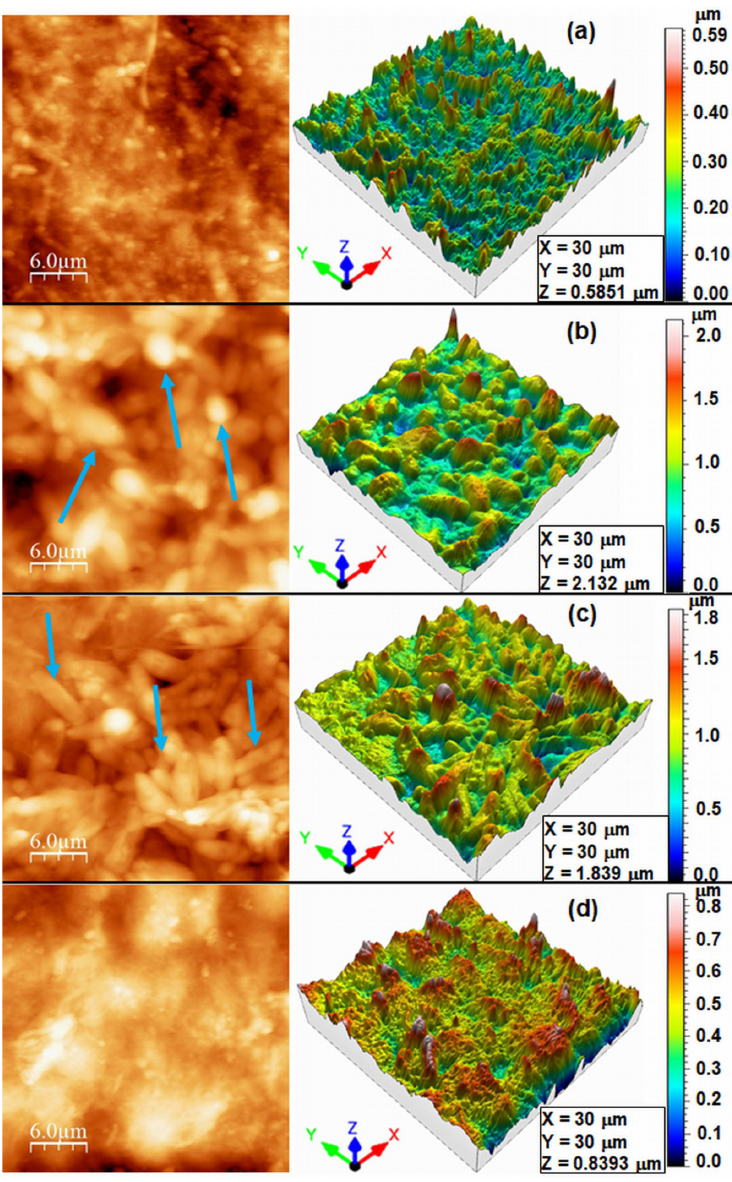
Figure 4. Relevant 2D and 3D AFM micrographs of samples: a) Bio0, b) Bio25, c) Bio50, and d) Bio75. Blue arrows indicate bacteria in b) and yeasts in c). Table 1. More relevant superficial parameters S